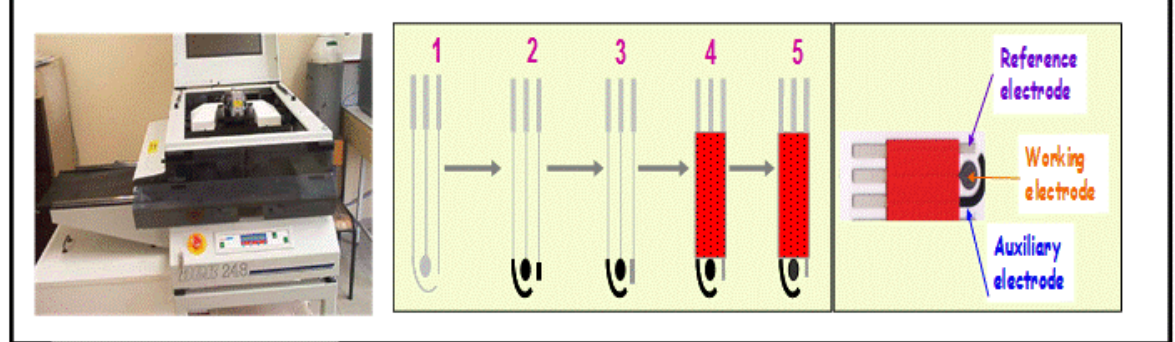
Figure 2. Fabrication of a three electrode system. Chemically inert substrate; screen printing of working and auxiliary electrode; screen printing of reference electrode; screen printing of protection paste; working electrode incubation with the analyte of interest (IMAGES, Perpignan,